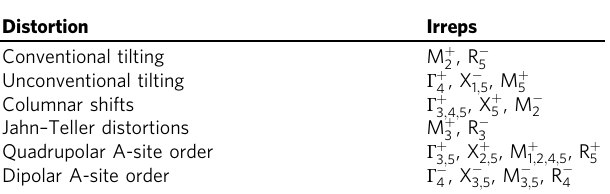
Table 1 The irreps corresponding to the different distortions considered Distortion Irreps Conventional